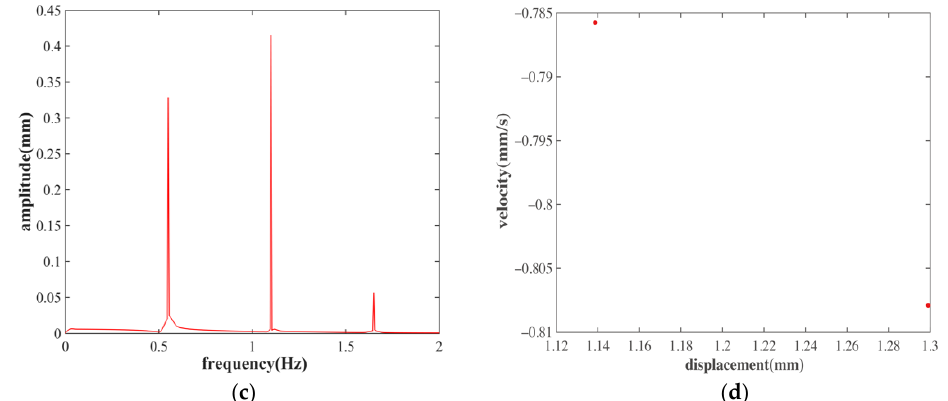
Figure 14. Nonlinear response of the GMA system at α = 0.83: ( a ) Time domain waveform diagram; ( b ) Phase trajectory curve; ( c ) Amplitude spectrum; ( d ) Poincaré diagram.